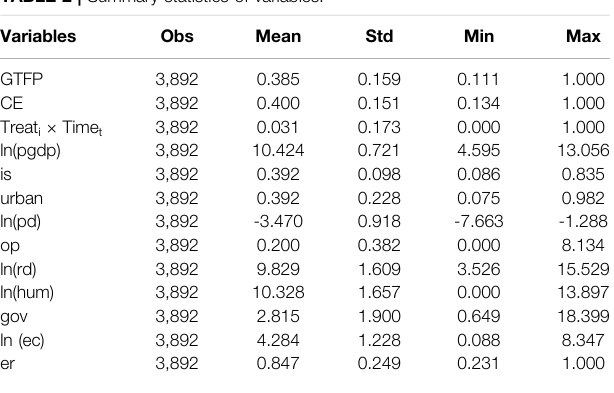
TABLE 2 | Summary statistics of